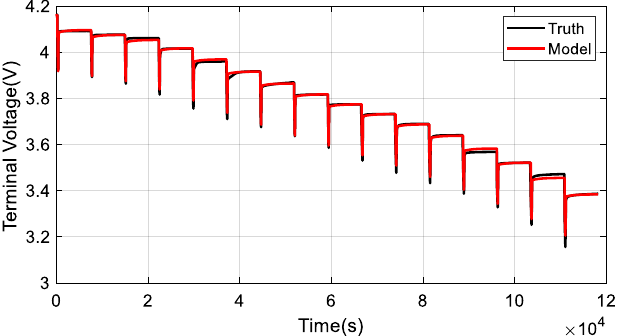
Figure 6. True value and modeled values of terminal voltage.